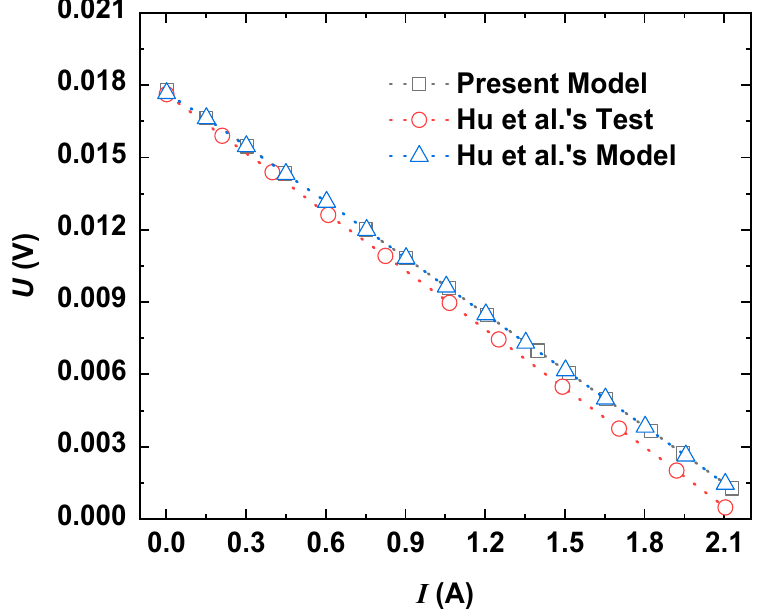
Figure 6. Results comparison according to I - U curves between Hu et al.’s report [49] and the present simulations.